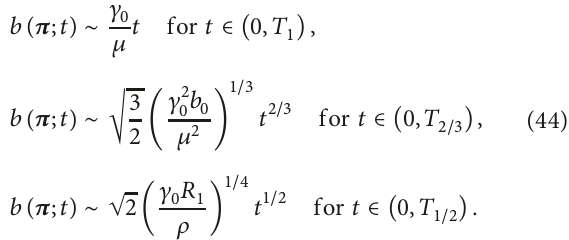
Figure 8. The placement of arrows on the u curves of Figure 8 serve merely to indicate the evolution of time evolution of these curves. In Figure 8, the graphs of the velocity norm ‖ u ‖ correspond to the sequence of times (𝑡 𝑘 ) 5 𝑘=0 = (10𝑘) [ms]. The nature of these curves are now explained.